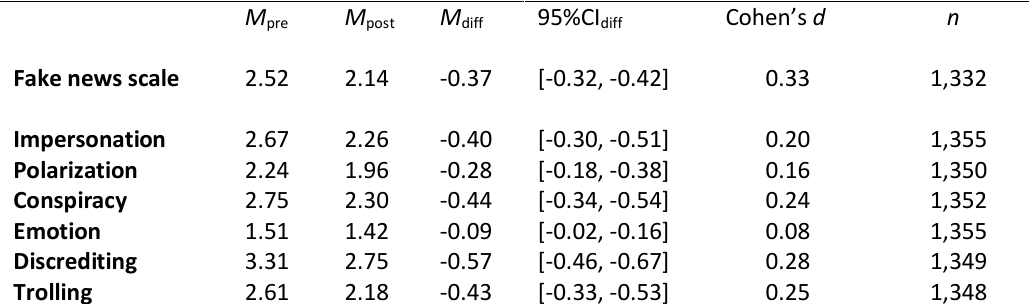
Table 6. Average reliability (pre-post) judgments overall and for each fake news badge by country (Poland).